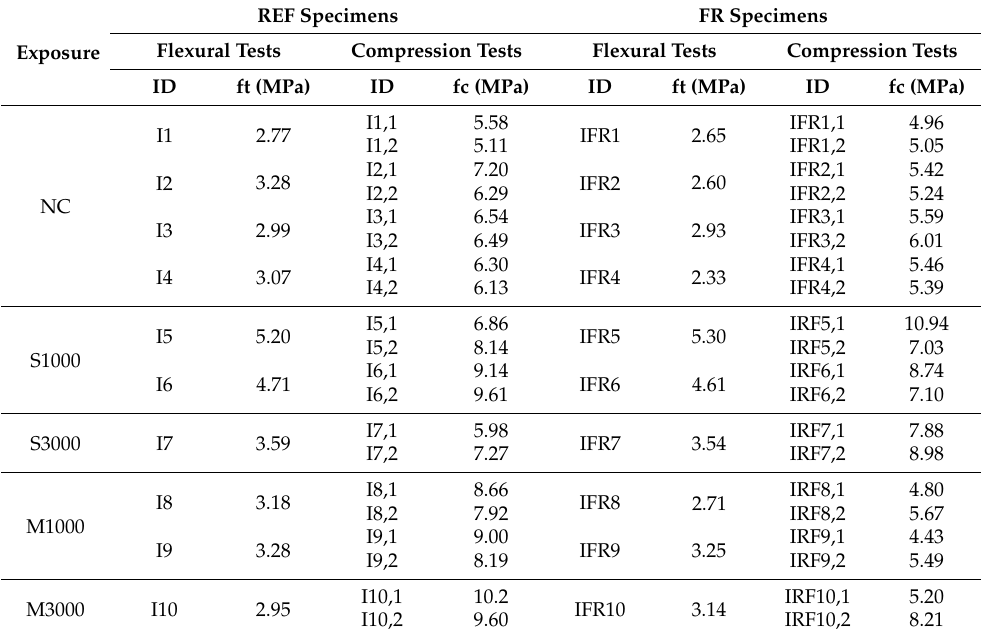
Table A1. Detailed results of flexural and compression tests of specimens of Mixture 1.